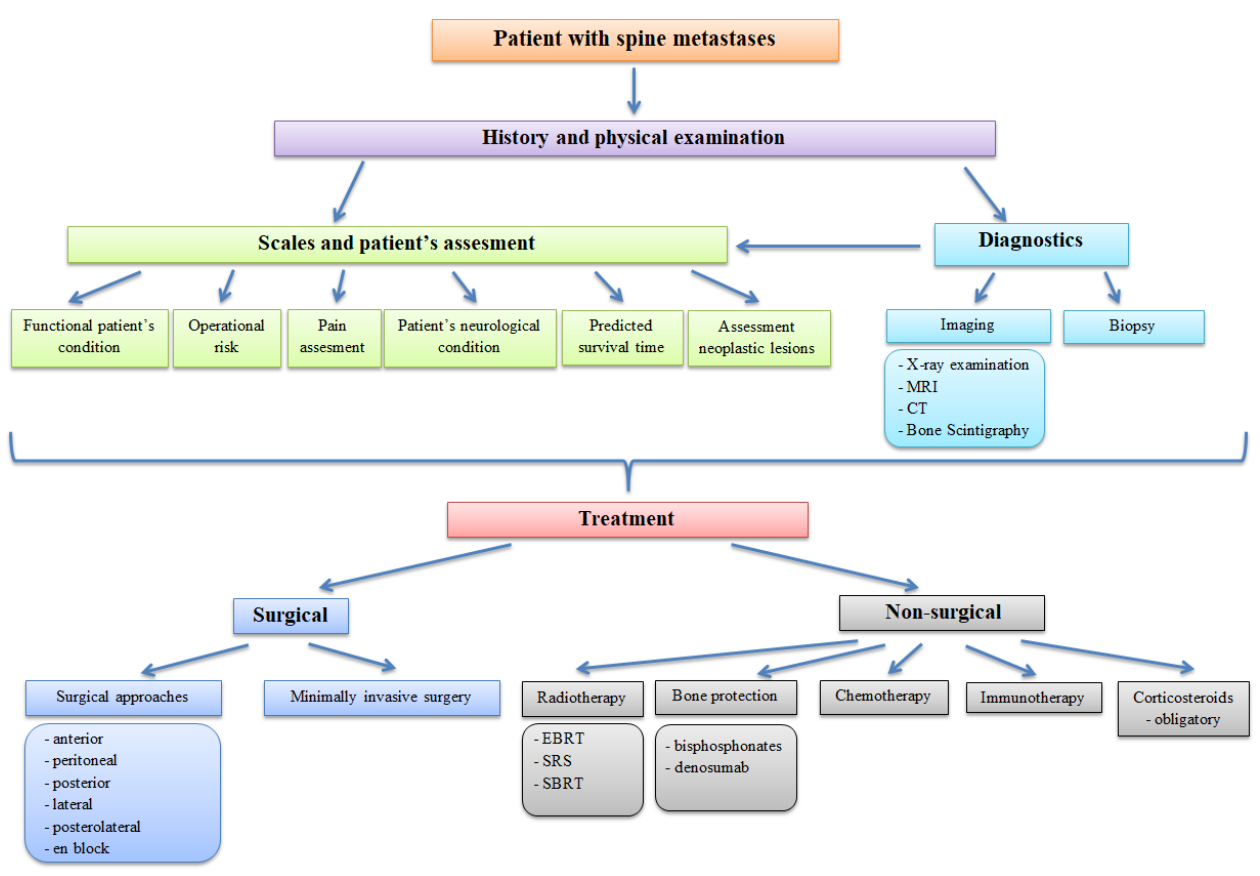
Figure 2. The algorithm summarizing the diagnostic and treatment strategy for patients with spinal metastases, based on data presented in the review.